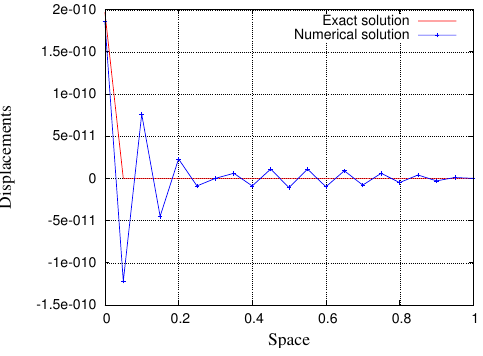
Figure 5. Comparison between an accurate enough approximation of the analytical solution and an approximated solution for displacements, obtained by scheme (2.7) for the column problem at time T = 0 . 001 and N = M = 20.